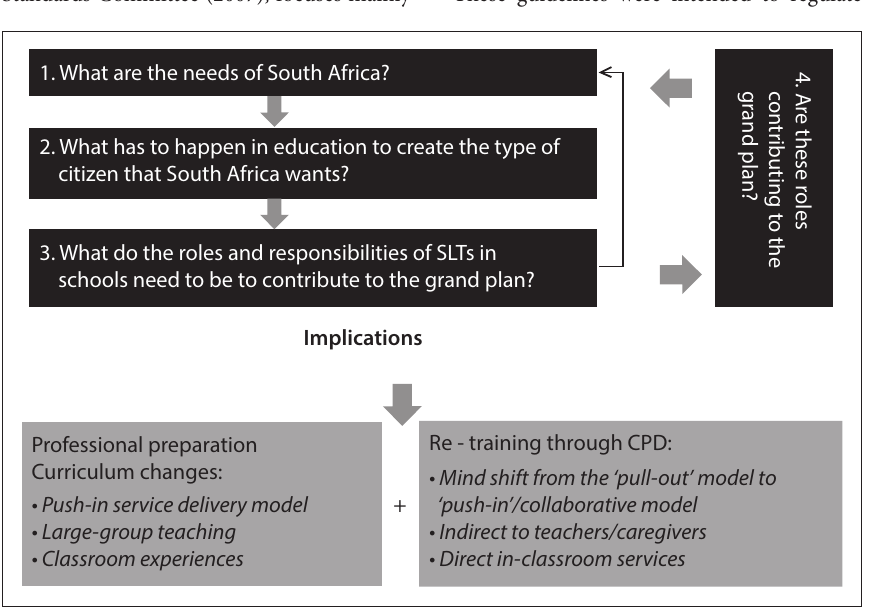
Fig. 1. A critical review of the roles and responsibilities of SLTs in schools (based on Ehren, 2011 in Kathard et al .,